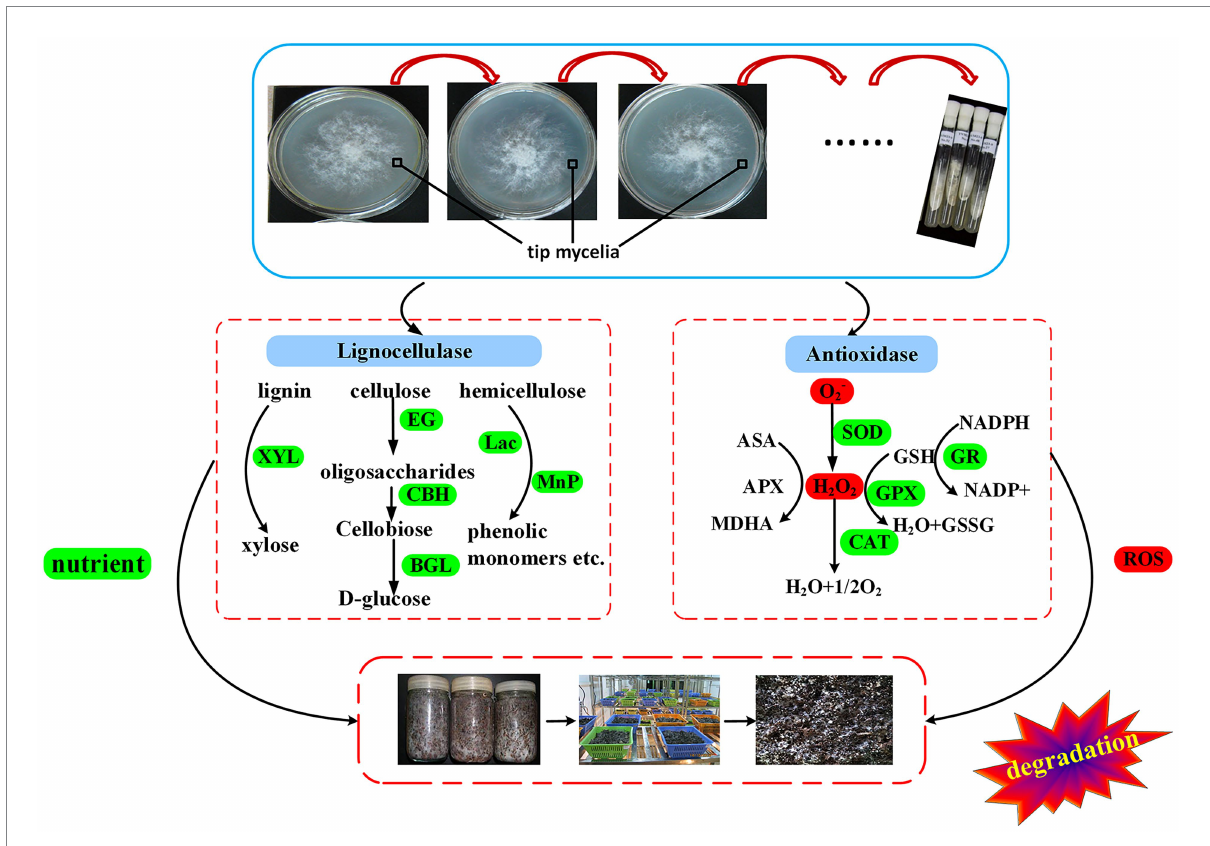
FIGURE 6 Schematic representation of the degeneration mechanism of Volvariella volvacea during